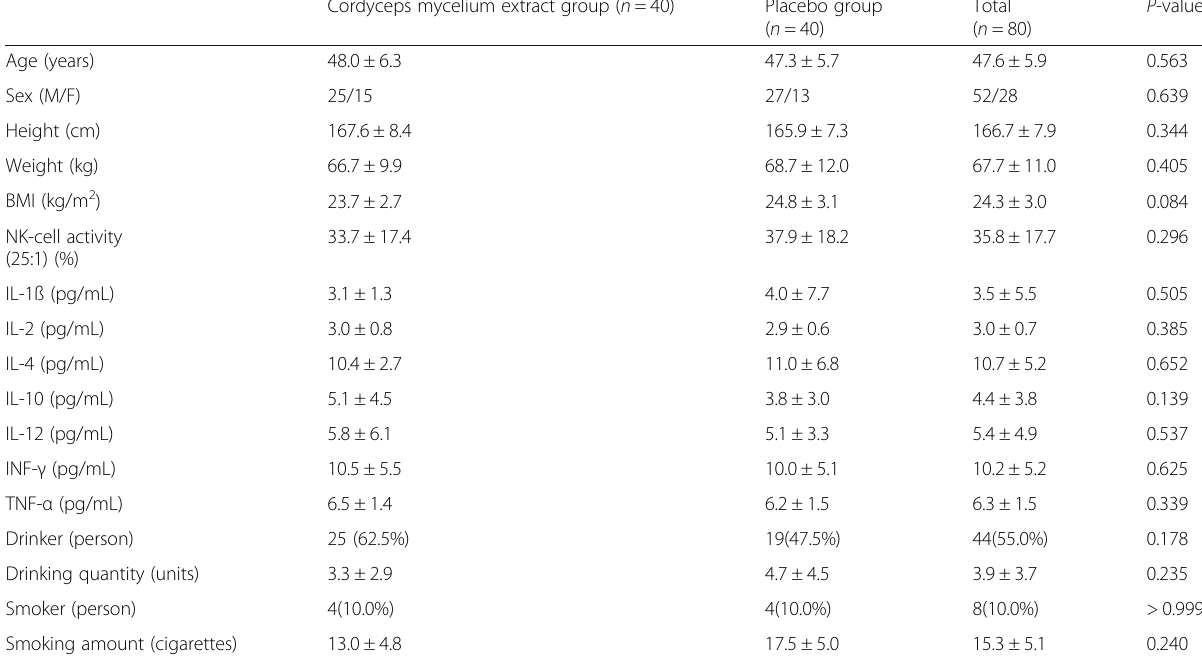
Table 2 Study participant demographic characteristics Cordyceps mycelium extract group ( n = 40) Placebo group